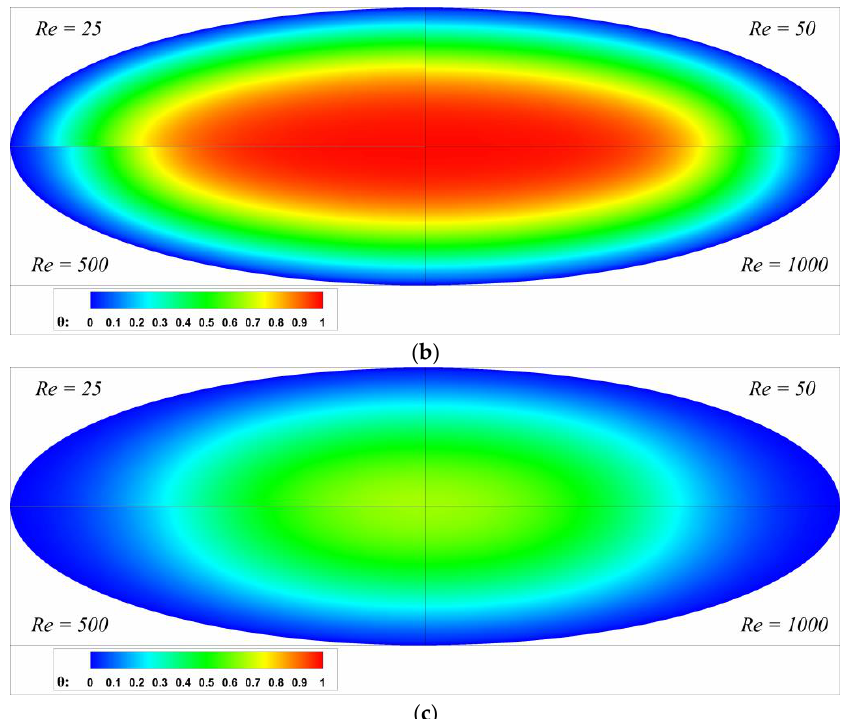
Figure 5. Dimensionless temperature profiles of different Reynolds numbers for ε = 0.33 at ( a ) x * = 0.001, ( b ) x * = 0.01 and ( c ) x * = 0.05.